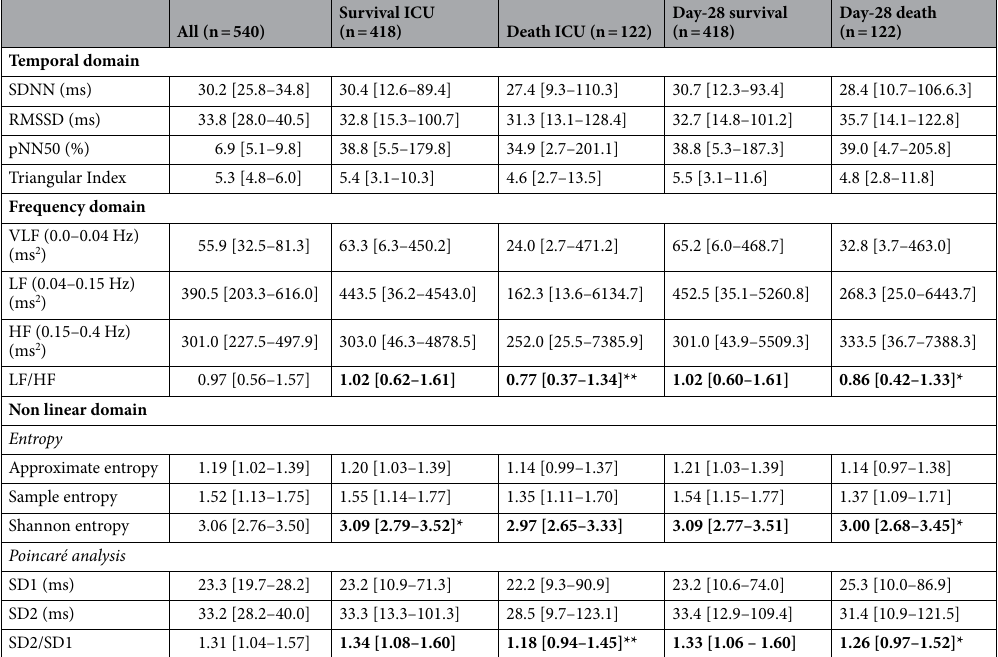
Table 2. Comparison between HRV values measured on admission, according to ICU and Day-28 mortality. HF high frequency, LF low frequency, LF/HF ratio of low frequency to high frequency, NN normal interbeat, pNNx percentage of consecutive NNs that vary by more than “x” ms, RMSSD root mean square of successive differences, SD1 standard deviation 1, SD2 standard deviation 2, SD2/SD1 ratio SD2/SD1, SDNN standard deviation of NN, VLF very low frequency. Significant values are in bold. *P ≤ 0.05; **P ≤ 0.005; ***P ≤ 0.0001.